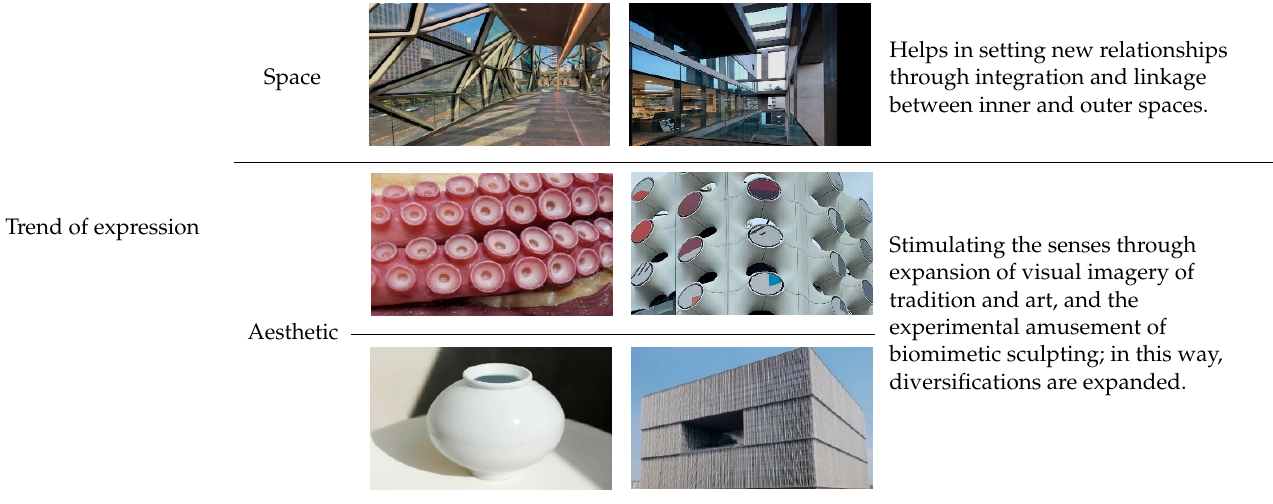
Table 3. Structural facades: Urban Hive (Archium 2008).